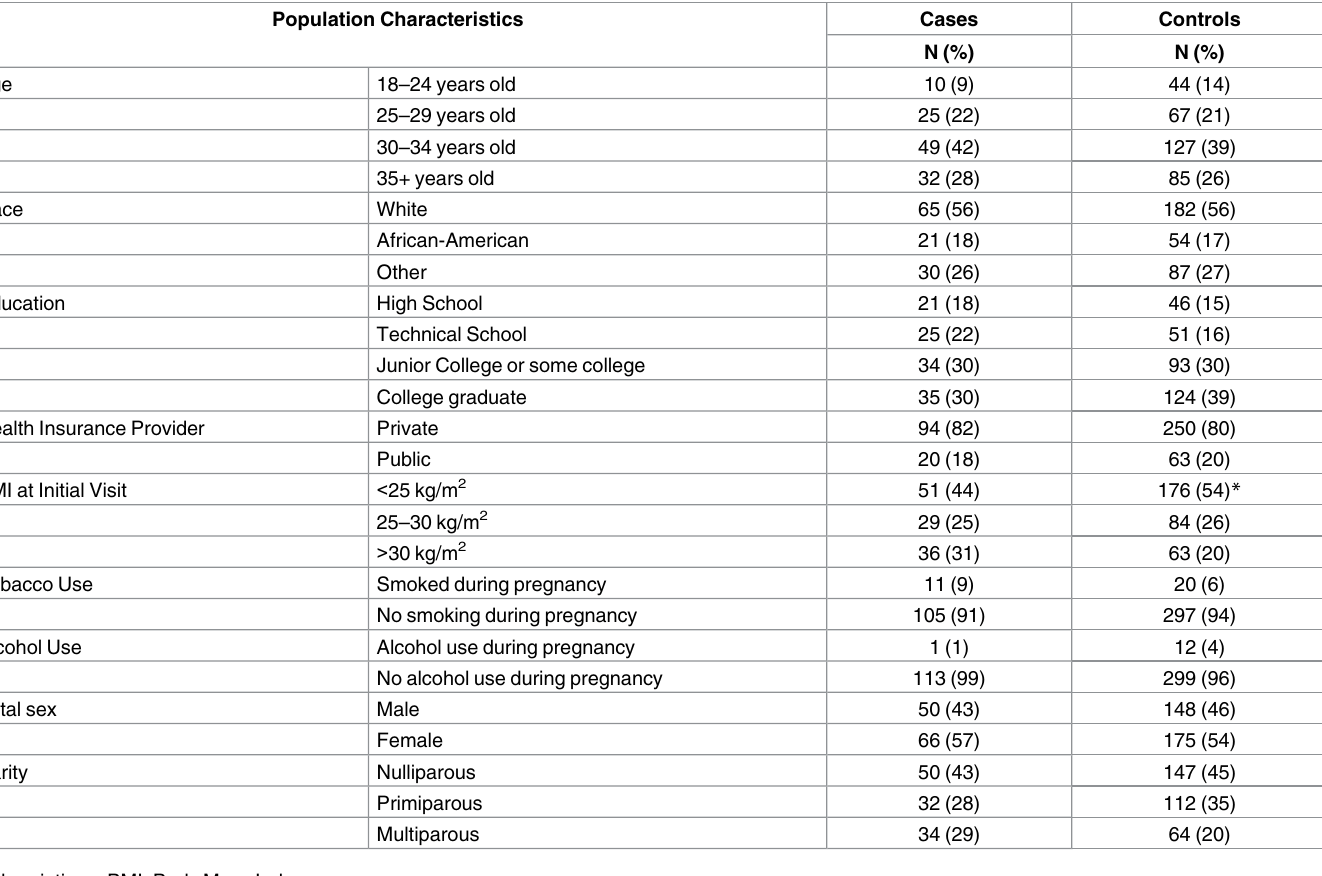
Table 1. Population demographic characteristics by cases (N = 116) and controls (N =